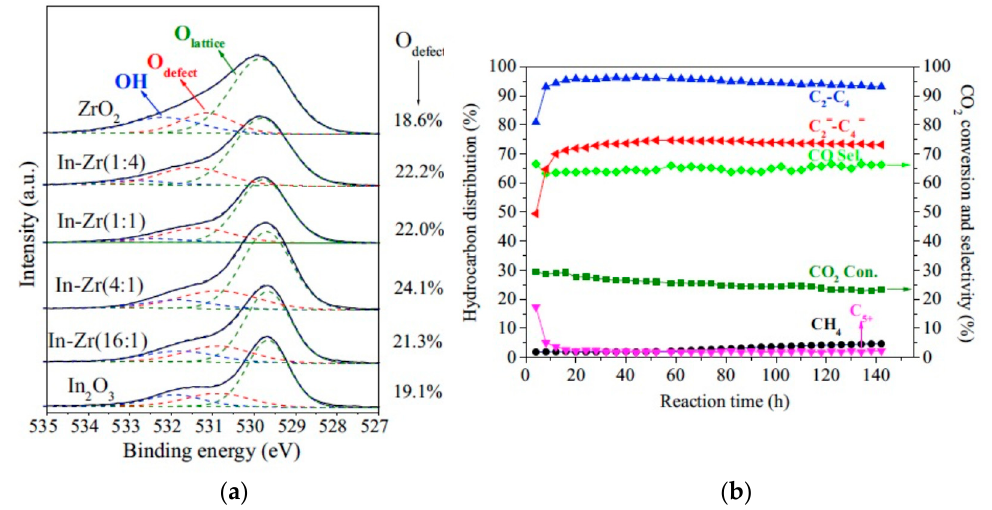
Figure 22. ( a ) XPS spectra (O1s) of various oxides and the content of surface oxygen vacancies (O v ). ( b ) The stability tests of the bifunctional composite catalysts In-Zr(4:1)/SAPO-34 (testing conditions: T = 653 K, P = 3.0 MPa, GHSV = 9000 mL gcat − 1 h − 1 , molar ratio of H 2 /CO 2 /N 2 = 73/24/3, and mass ratio of oxide/zeolite = 0.5). Adapted with permission from ref. [18]. Copyright 2018 Elsevier.